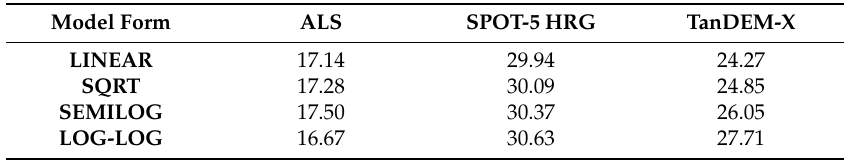
Table B1. Relative RMSE (%) values for mean diameter. Results for models based on ALS- and SPOT-5-based RS data are given for data collected in 2010 and results for TanDEM-X data are calculated using data from